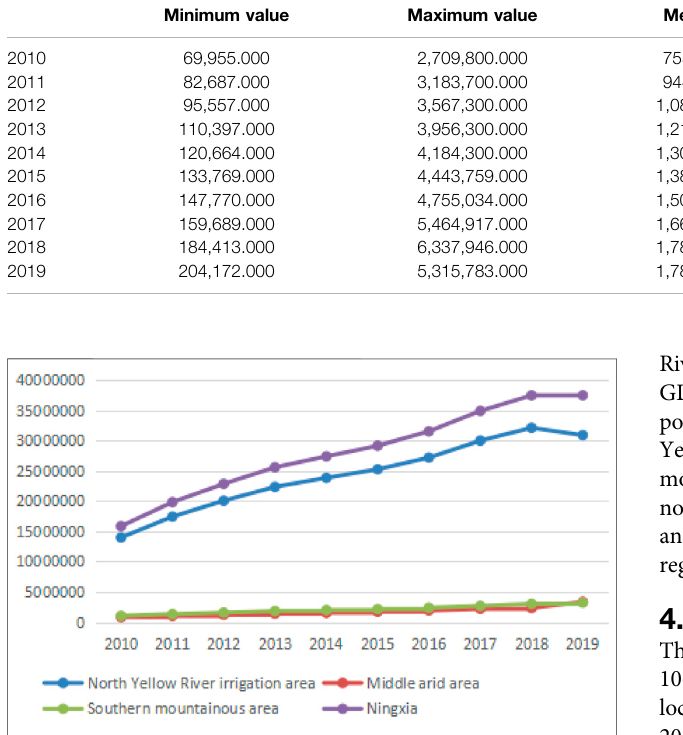
FIGURE 3 | The economic growth changes of 3 major subregions from 2010 to 2019 (yuan).